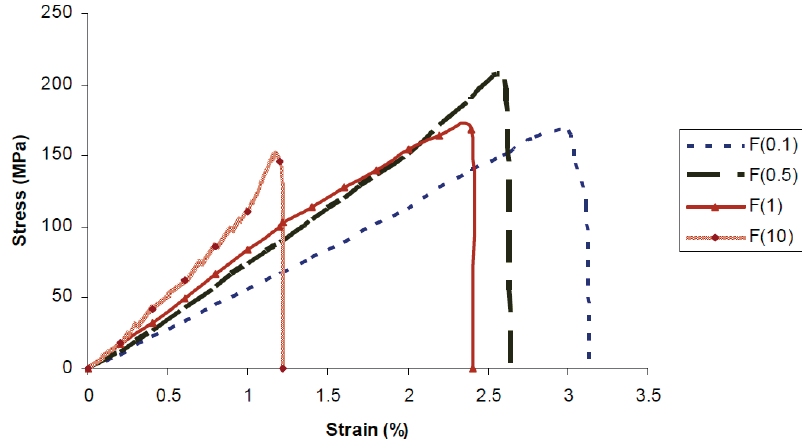
Figure 1. Representative stress–strain curves of banana fibers. Reproduced with permission from Journal of Engineered Fibers and Fabrics